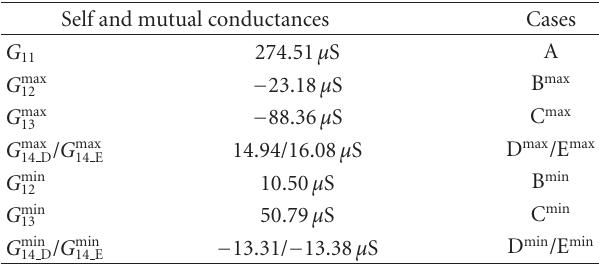
Table 3: Self and mutual conductances of coupled ridged circular